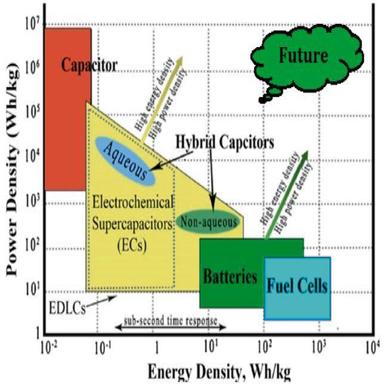
Ragone plot representing various energy storage systems. Reproduced from Ref.. .